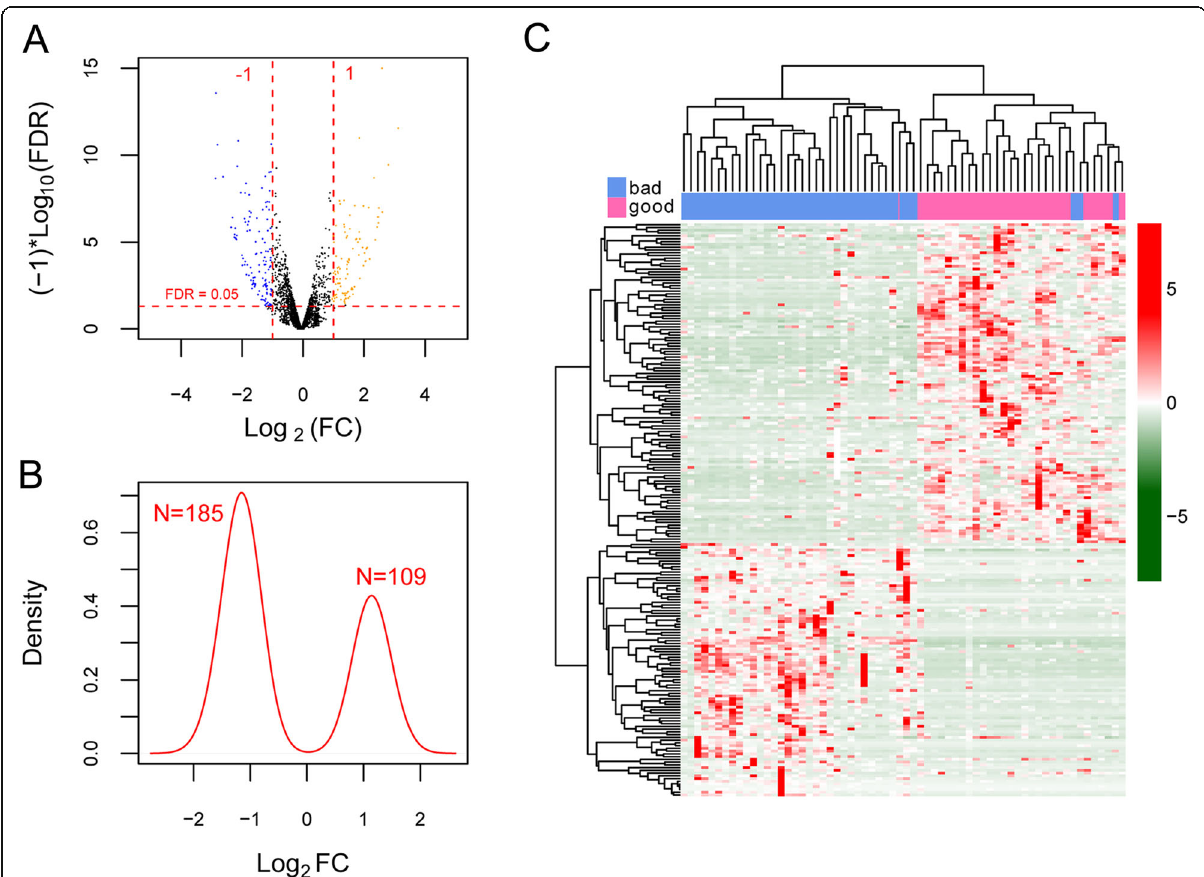
Fig. 1 Graphic representation of differentially expressed RNAs (DEGs) between good prognosis and bad prognosis patients. a , volcano plot of effect size (log 2 FC) and -log 10 (FDR) of DEGs. Blue and orange round spots stand for down- and up-regulated RNAs, respectively. Two red vertical dash lines signal |logFC| > 1, and red horizontal dash line signals FDR < 0.05. b , Kernel density plot for DEGs. c , a heatmap illustrating two-way hierarchical clustering of DEGs. Horizontal blue and pink bars indicate good prognosis and bad prognosis samples, respectively. Bad: